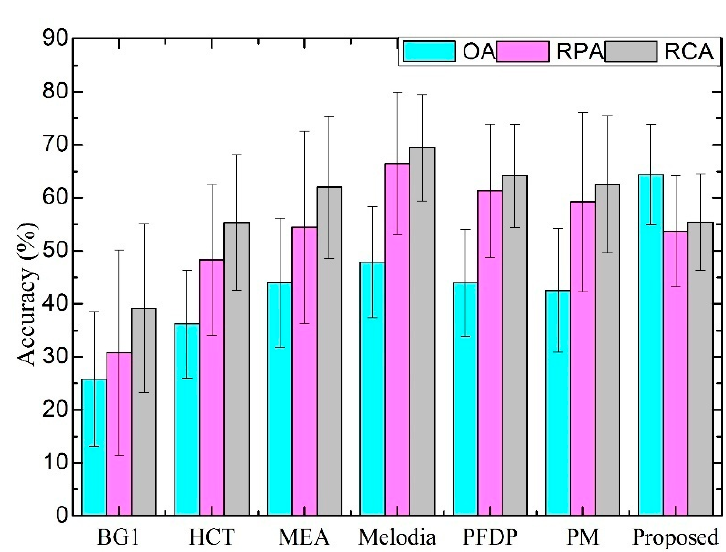
Appl. Sci. 2020 , 10, x FOR PEER REVIEW